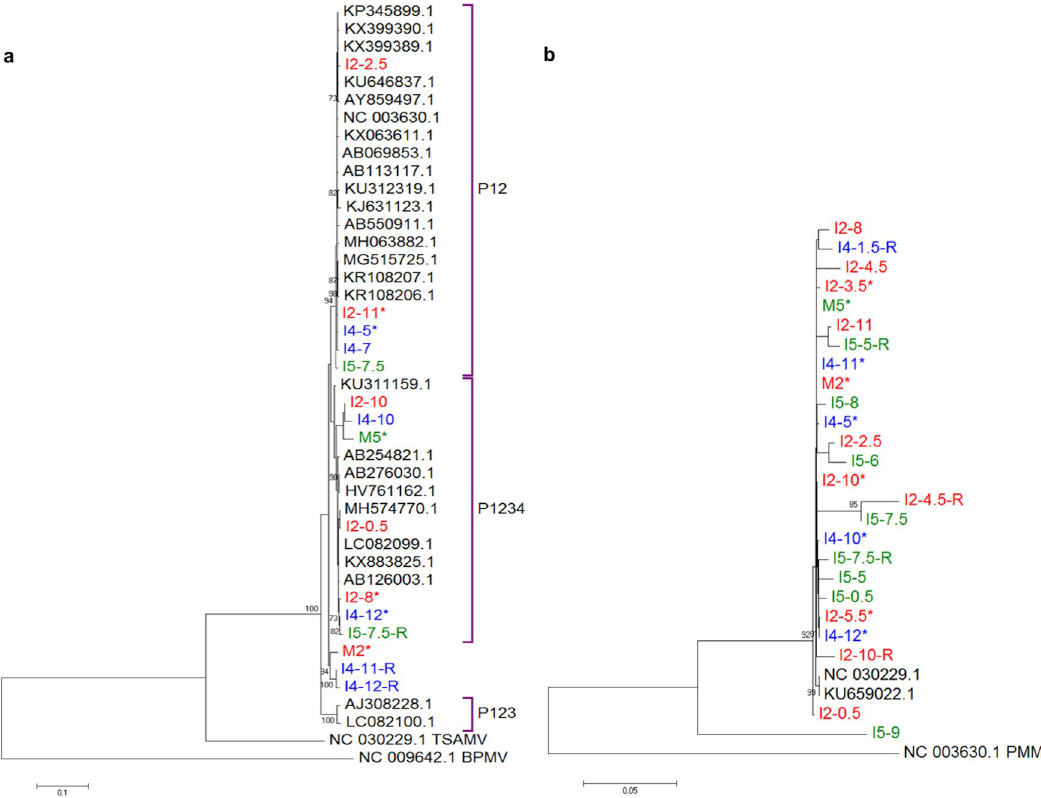
Figure 6. Phylogenetic trees of the complete genomes and partial sequences (contigs > 450 nt) of ( a ) PMMoV and ( b ) TSAMV. On the right side of the PMMoV tree, the pathotype of the reported reference strains is indicated. The colors indicate the different children and mothers’ samples. Following the initial code, e.g., M2 for mother 2, and I2 for infant 2; the month at which the sample was collected is shown. *, complete genomes. R, respiratory